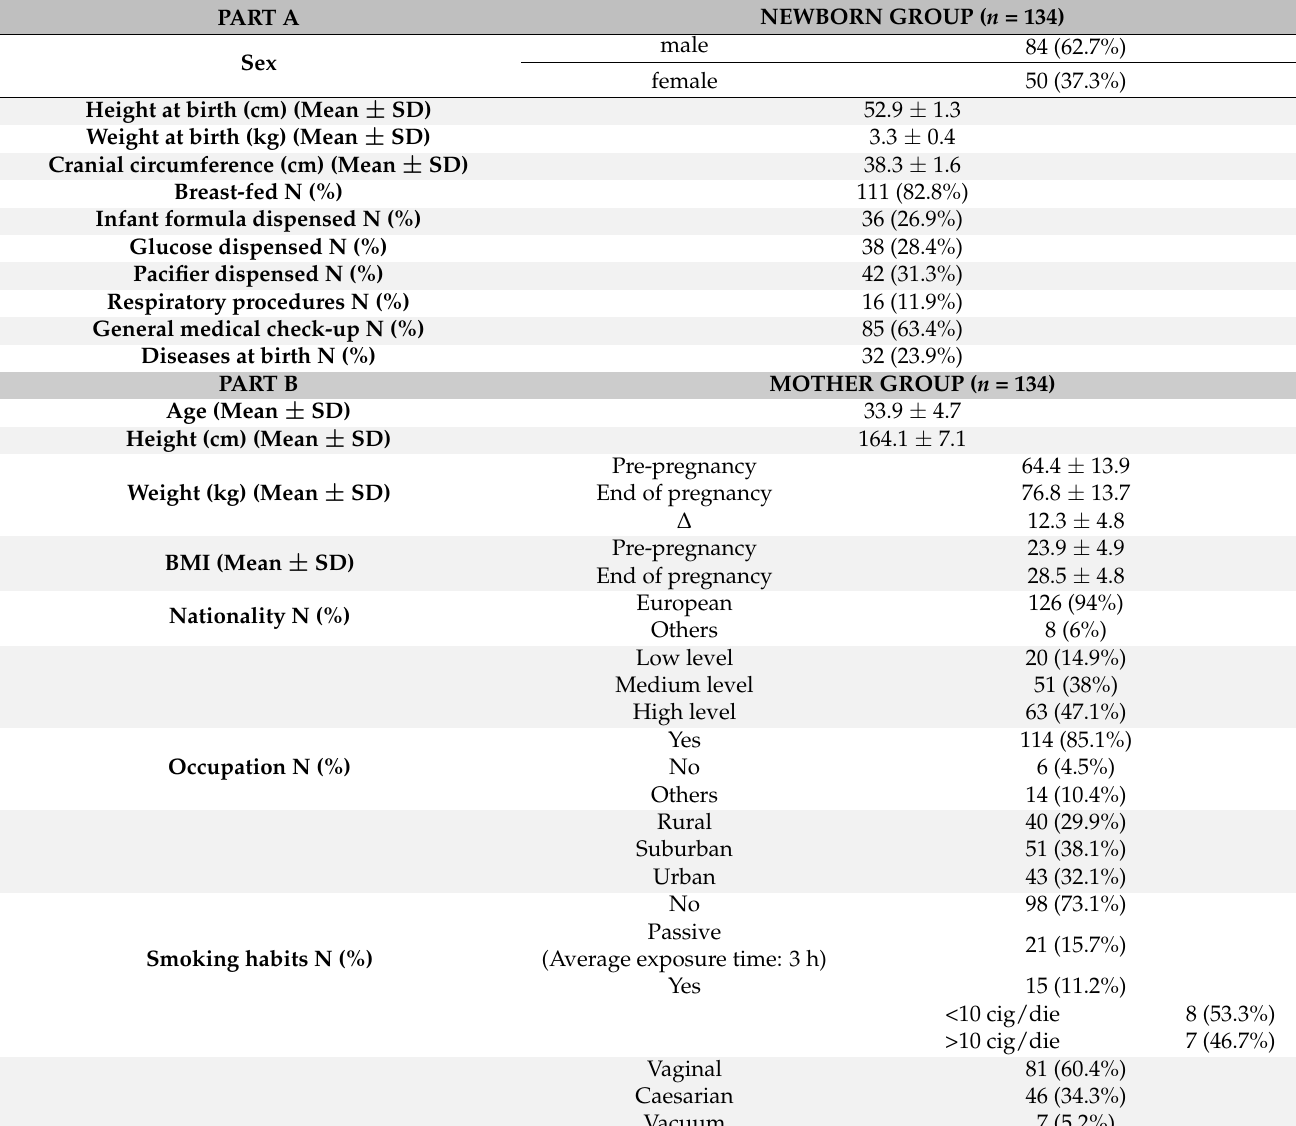
Table 2. Physical characteristics of the newborn sample at birth and BP (i.e., BPA and BPS) concentrations (part A); Characteristics of mother population (part